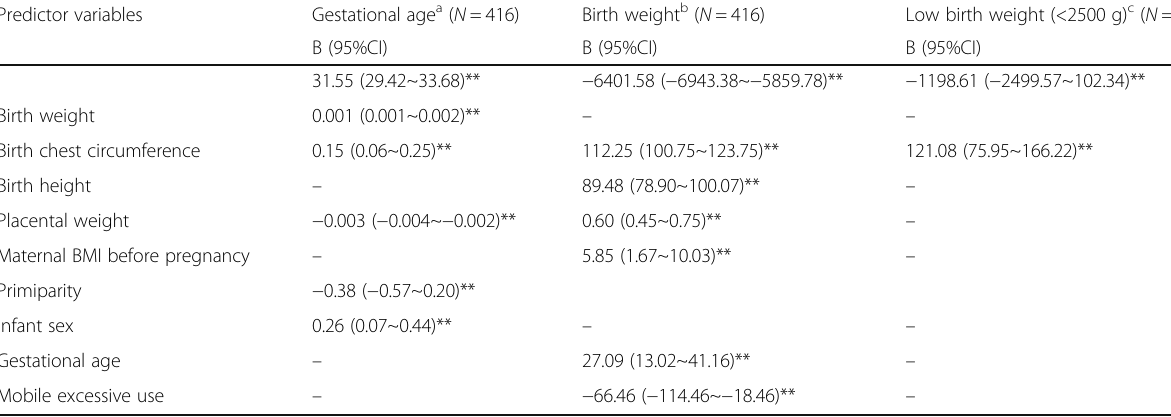
Table 3 Association between predictor variables and birth weight Predictor variables